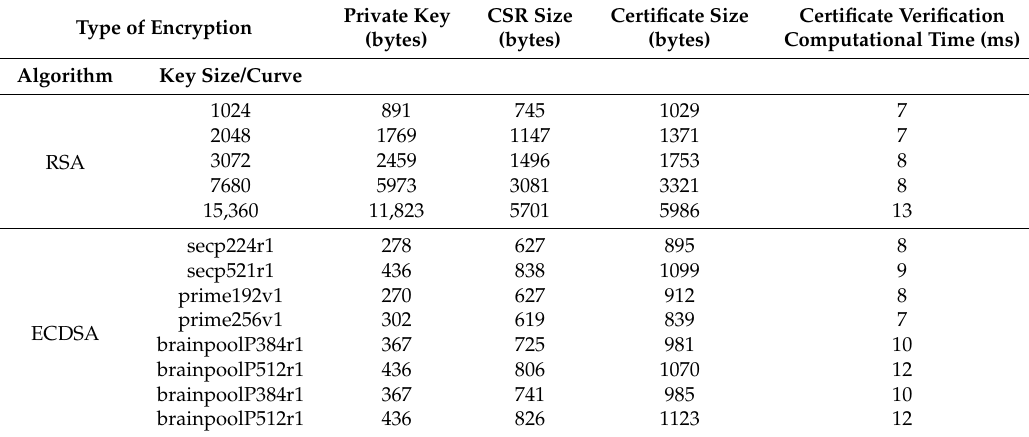
Table 1. Computational times for explicit certificate verification with different key sizes of RSA and ECDSA.